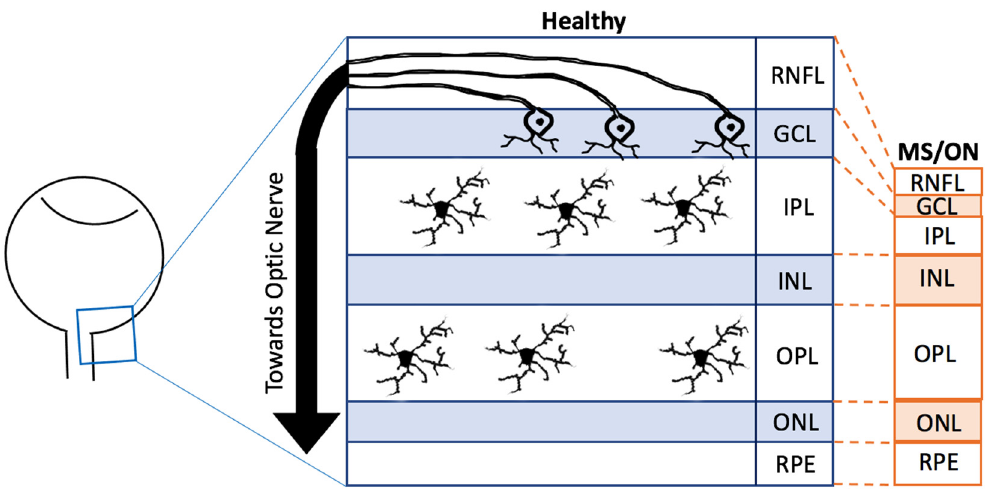
Figure 2. Comparison of retinal changes in Healthy and Diseased Retinas. A schematic diagram showing changes in the main layers in the healthy (blue) and MS/ON (multiple sclerosis/optic neuritis, orange) retinae. The diagram is not to scale and a hypothetical representation. The ganglion cell axons are found in the RNFL whilst their cell bodies are in the GCL. Microglia are said to reside in the IPL and OPL. There are also other retinal neurons and glia that are not specified in this diagram. RNFL = retinal nerve fibre layer, GCL = ganglion cell layer, IPL = inner plexiform layer, INL = inner nuclear layer, OPL = outer plexiform layer, ONL = outer nuclear layer, RPE = retinal pigment epithelium, MS = multiple sclerosis, ON = optic